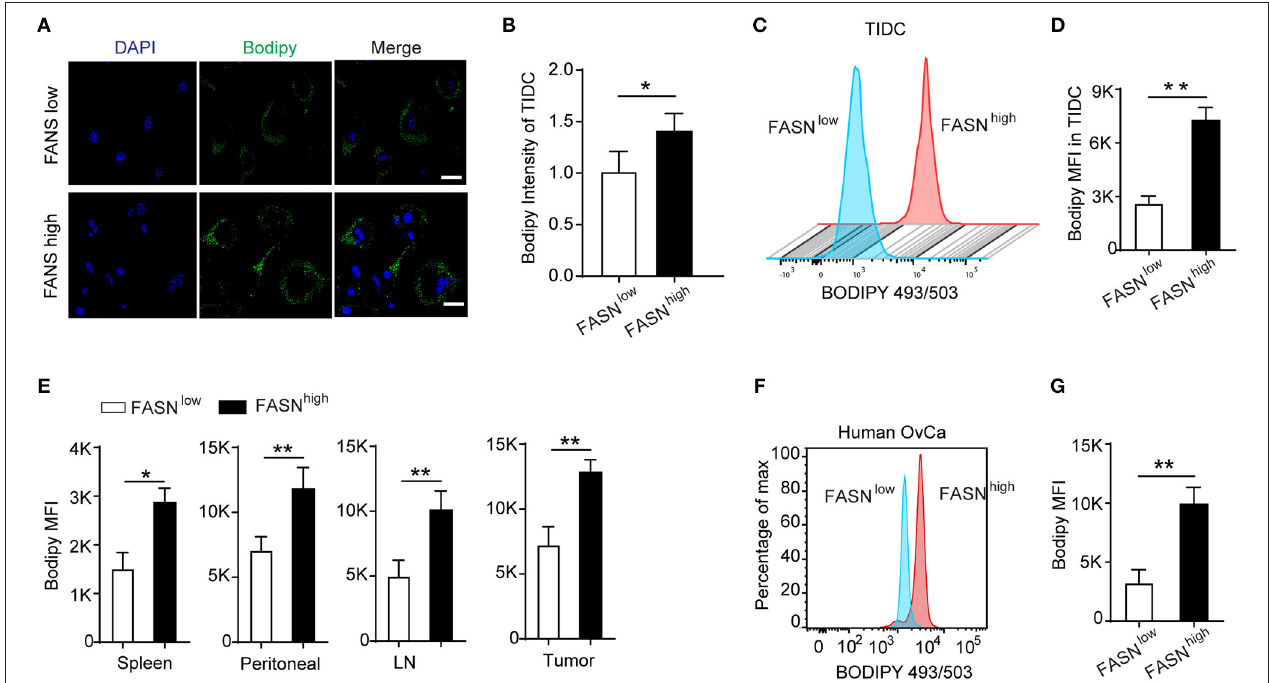
FIGURE 3 | Lipid accumulation in tumor-infiltrating DCs derived from the FASN high ovarian cancer accounted for its defective function. (A) Staining of sorted tumor-infiltrating dendritic cells (TIDCs) from FASN low or FASN high ID-8 tumor-bearing mice with BODIPY 493/503. Representative images are shown; scale bar, 20 µ m. Green, BODIPY 493/503; blue, DAPI. (B) Immunofluorescence intensity of BODIPY 493/503 in TIDCs was measured by Image J and quantification was shown ( n = 5). (C) Flow cytometry analysis of lipid level in TIDC from FASN low or FASN high ID8 tumor-bearing mice. (D) Geometric mean fluorescence intensity (MFI) of BODIPY 493/503 in TIDCs was measured. Each group includes five mice. FASN low and FASN high ID8 tumor-bearing mice were evaluated in parallel in each experiment. (E) Quantification of lipid level in MHC-II + CD11c + DCs from spleen, ascites, lymph node, and tumor in FASN low or FASN high ID-8 tumor-bearing mice. (F) Flow cytometry analysis of BODIPY 493/503 staining of TIDCs from an individual with ovarian cancer showed human TIDCs also have high lipid level. (G) Cumulative results of lipid levels in TIDCs from individuals with OvCa. Data = mean ± SEM; representative of at least 3 independent experiments; * P < 0.05; ** P < 0.01.